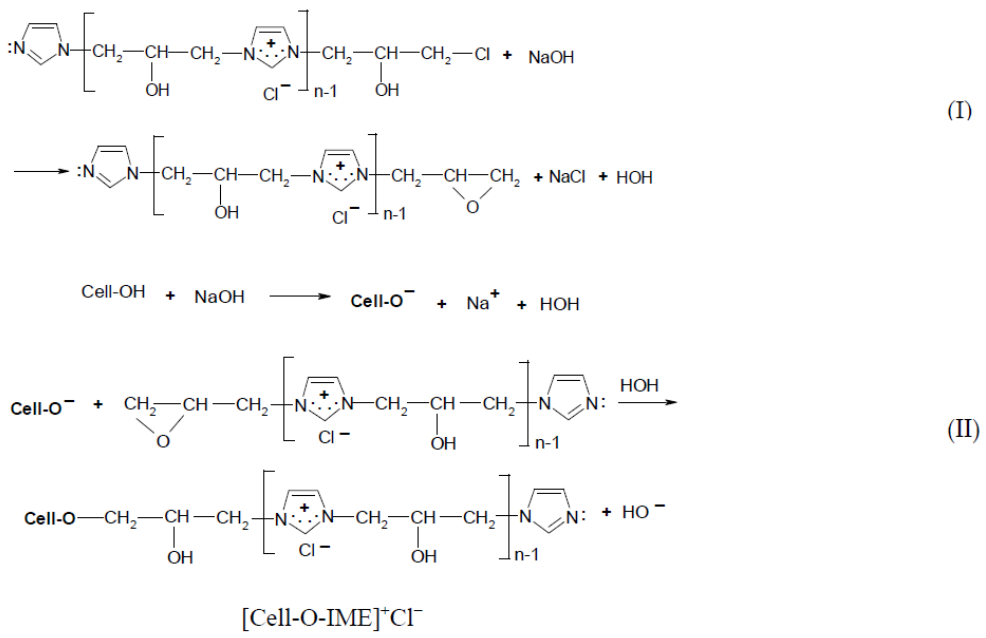
Figure 2. Two-step reaction of cellulose cationisation with [IME] + Cl − l ( I ) step = epoxy-form of [IME] + Cl − and celulosan anion formation. ( II ) step = covalent bond formed of [IME] + Cl − with cellulose.